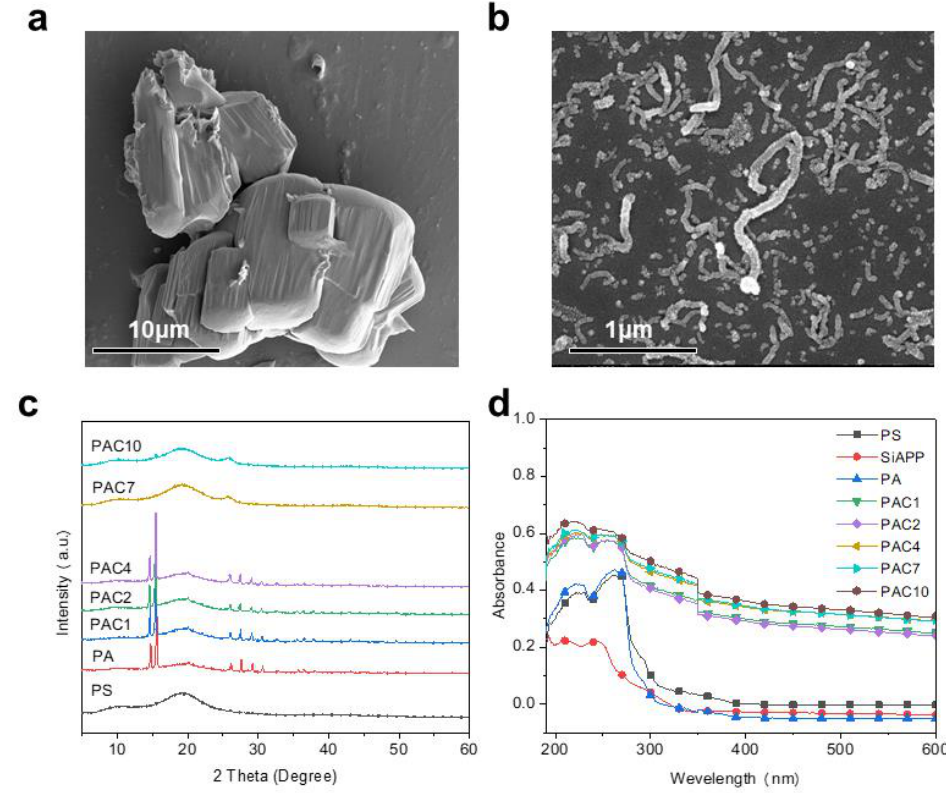
Figure 1. SEM images of ( a ) SiAPP and ( b ) aMWCNT and ( c ) XRD patterns and ( d ) UV-vis absorption spectra of PS and its composites.